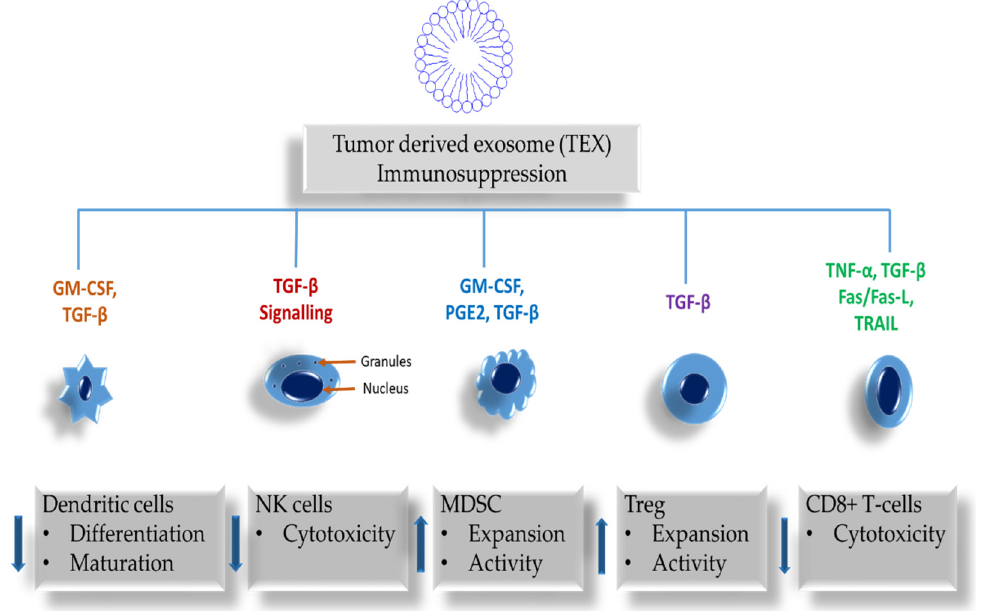
Figure 3. The effects of tumor-derived exosomes (TEX) on immune cells—Inhibition of immune cell proliferation (down arrows indicates down-regulation and up arrows indicates up-regulation): Apoptotic induction of activated CD8+ T-cells, induced by up-regulated TGF- β or by inhibitory signals. Suppression of NK cell activity through exosomal TGF- β and toll-like receptor (TLR) activation. Interference with monocyte differentiation and the promotion of Treg, including the expansion of MDSC.